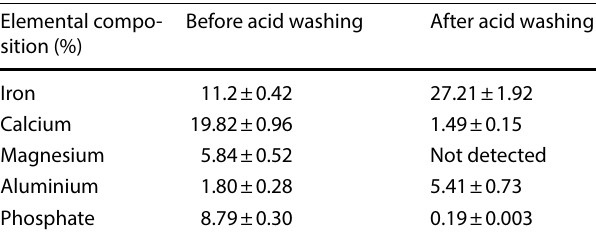
Table 3 XRF results showing elemental composition of the slag before and after acid washing Elemental compo- Before acid sition (%)